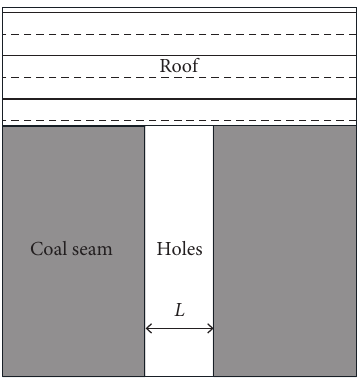
Figure 10: Equivalent aperture.